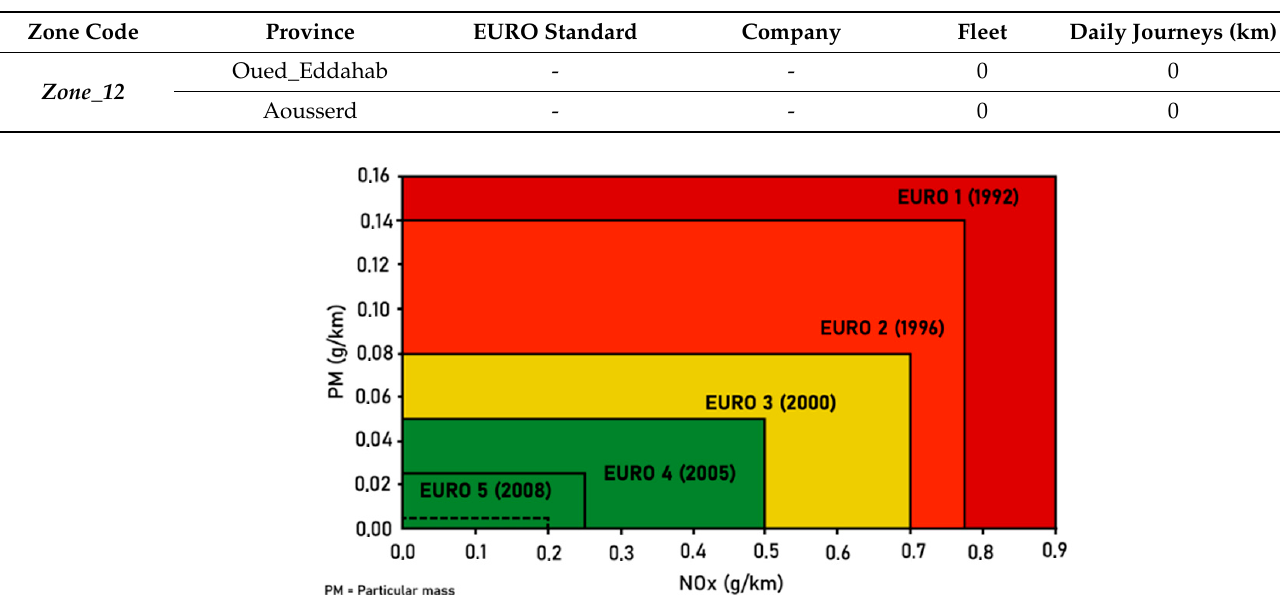
Figure 5. Emissions Standards for Diesel Engines [23].